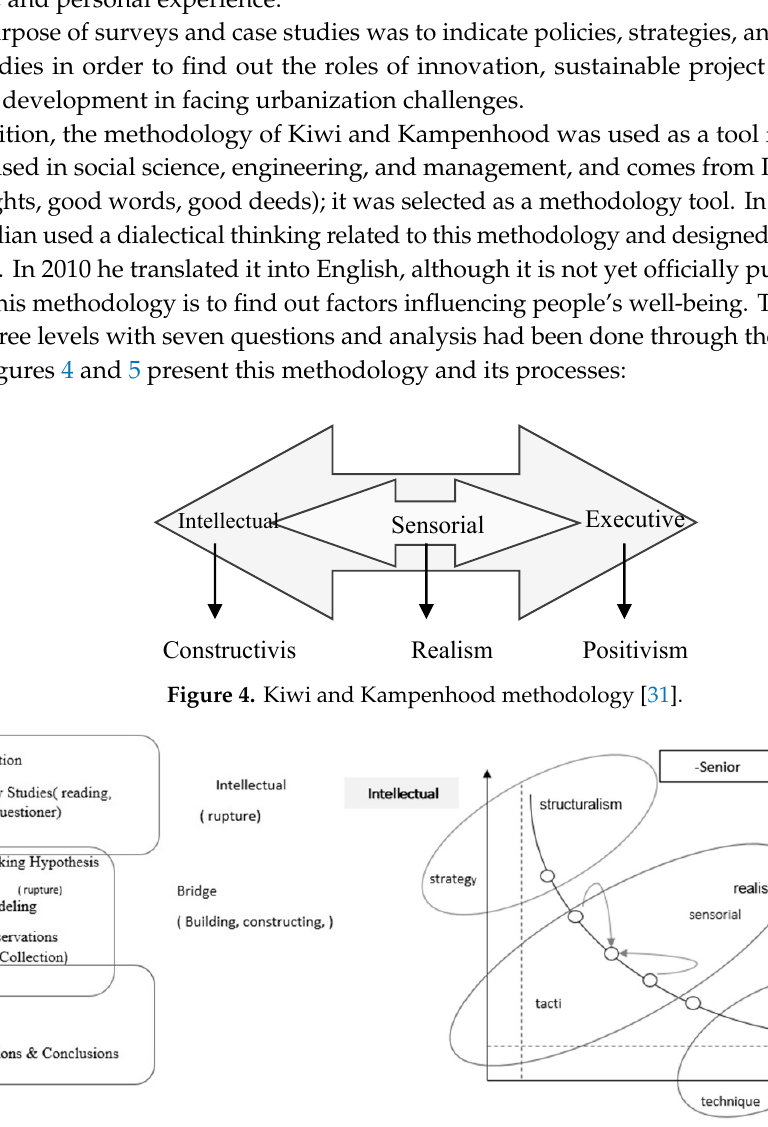
Figure 5. Revised diagram concerning Kiwi and Kampenhood methodology and its levels [31].